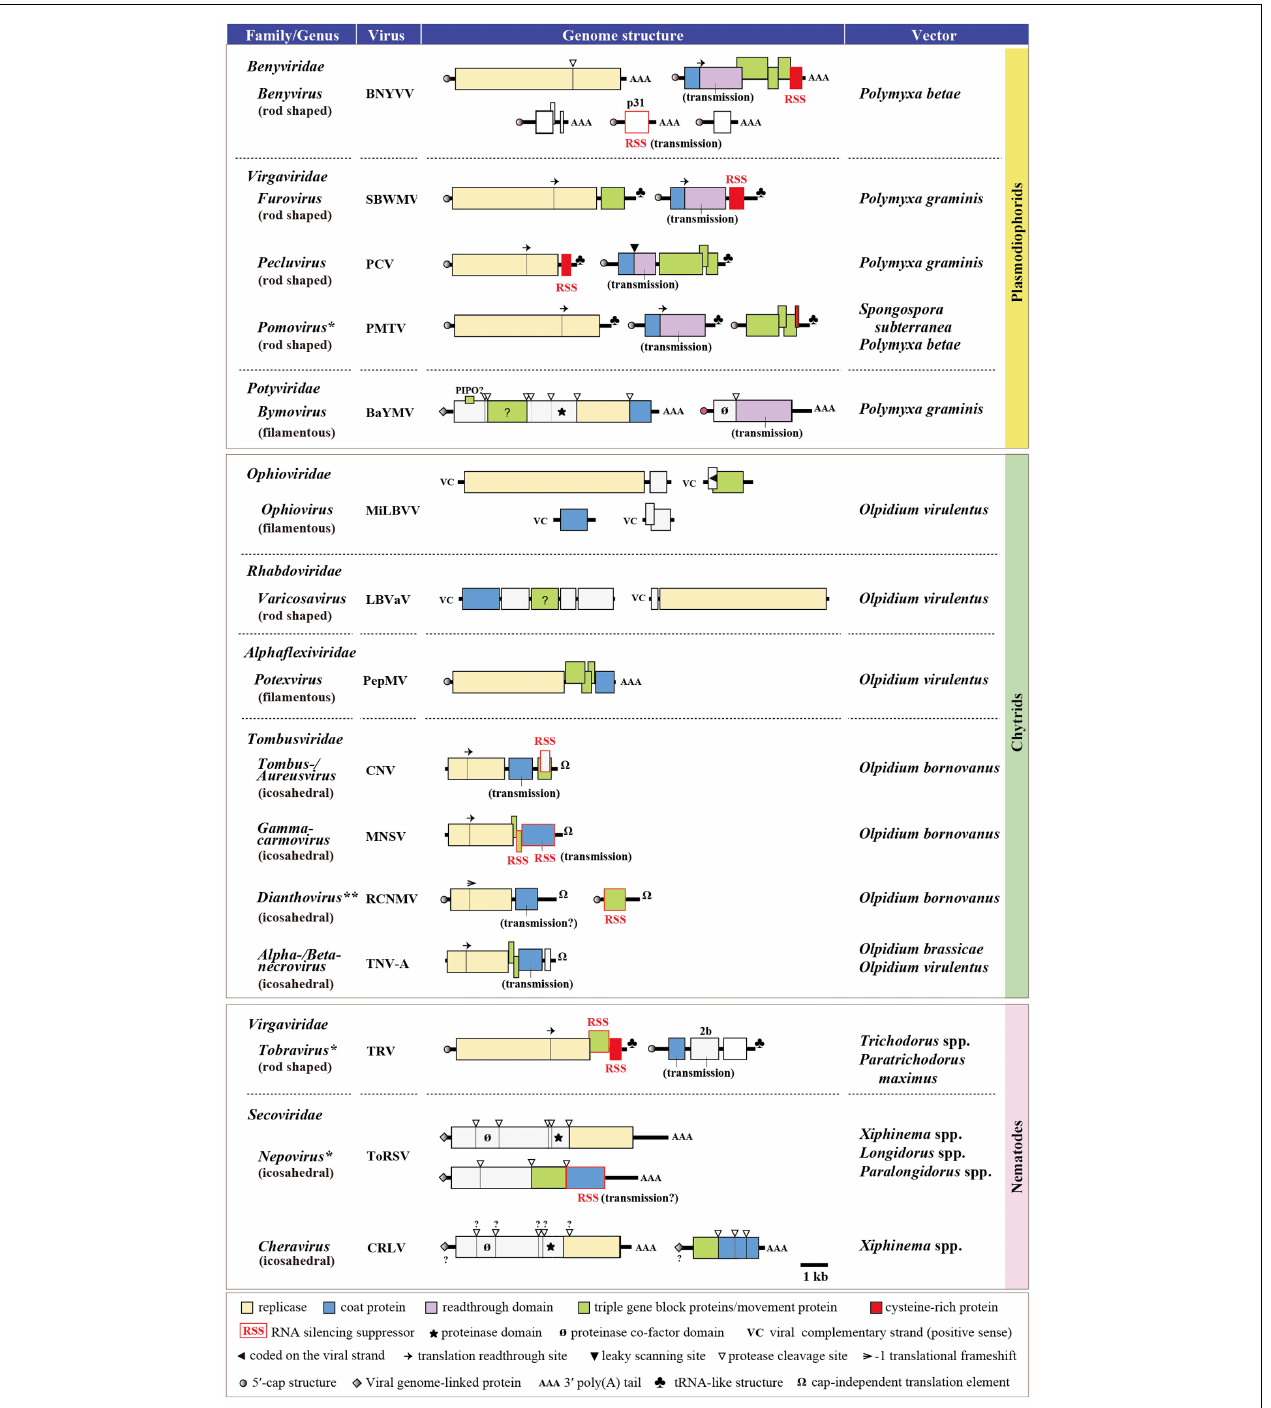
FIGURE 1 | Genome structure of the representative soil-borne plant viruses. The type species member from each virus genus is presented except for the MiLBVV, PePMV, cucumber necrosis virus (CNV), melon necrotic spot virus (MNSV), and RCNMV, which are selected because they are transmitted by soil-borne vectors, while the vector of other members within the same genus is unknown and/or insects. ∗ Some members of these genera are also known as seed transmissible. ∗∗ A member of this genus (carnation ringspot virus) is transmitted by both Longidorus and Xiphinema spp. BNYVV, beet necrotic yellow vein virus; SBWMV, soil-borne wheat mosaic virus; PCV, peanut clump virus; PMTV, potato mop-top virus; BaYMV, barley yellow mosaic virus; MiLBVV, mirafiori lettuce big-vein virus; LBVaV, lettuce big-vein associated virus; PepMV, pepino mosaic virus; CNV, cucumber necrosis virus; MNSV, melon necrotic spot virus; RCNMV, red clover necrotic mosaic virus; TNV-A, tobacco necrosis virus-A; TRV, tobacco rattle virus; ToRSV, tomato ringspot virus; CRLV, cherry rasp leaf virus.